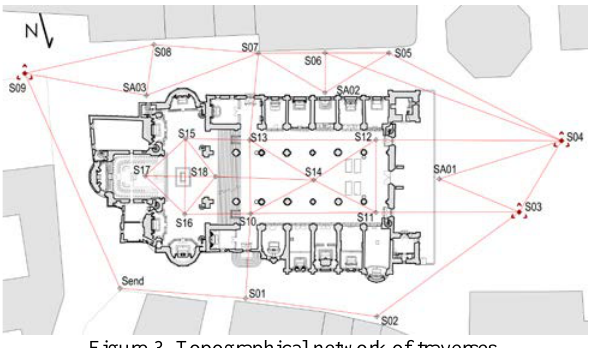
Figure 3_Topographical network of